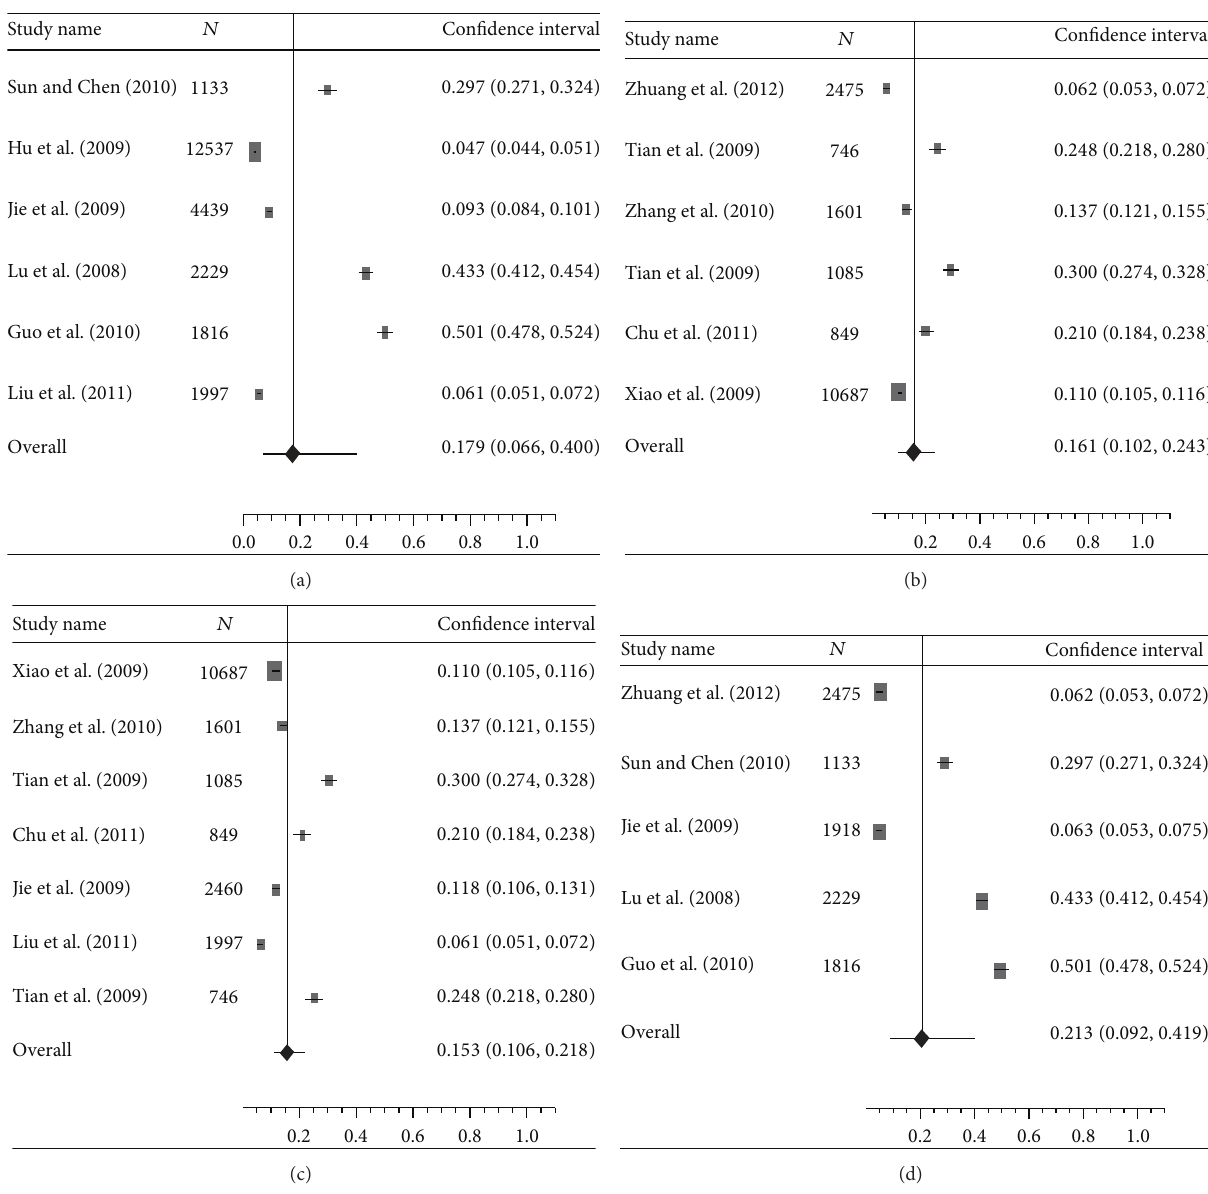
Figure 3: (a) A forest plot displaying the pooled prevalence of DES in individuals living in Northern China. (b) A forest plot displaying the pooled prevalence of DES in individuals living in Southern China. (c) A forest plot displaying the pooled prevalence of DES in individuals living in urban China. (d) A forest plot displaying the pooled prevalence of DES in individuals living in rural